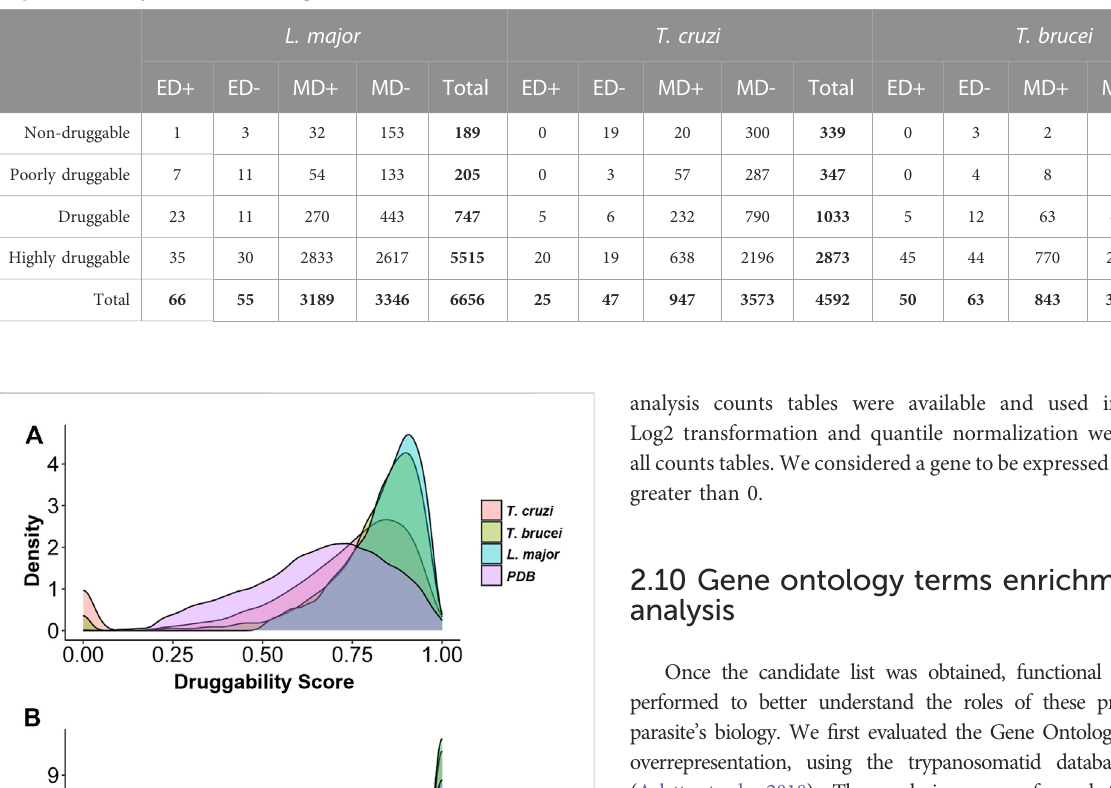
TABLE 1 Classi fi cation of Trypanosoma cruzi , Trypanosoma brucei and Leishmania major structures. Proteins were grouped based on their Druggability Score ( DS ) into four sets: non-druggable (0.0 ≤ DS < 0.2), poorly druggable (0.2 ≤ DS < 0.5), druggable (0.5 ≤ DS < 0.7) and highly druggable (0.7 ≤ DS ≤ 1.0). Additionally, we classi fi edallstructuresexperimentallyobtainedincomplexwithadrug-likecompoundoraninhibitor(ED+)orwithoutabindingdrug(ED-),andallmodelswhose template was co-crystallized with a drug (MD+) or not (MD-). Total values are shown in bold.